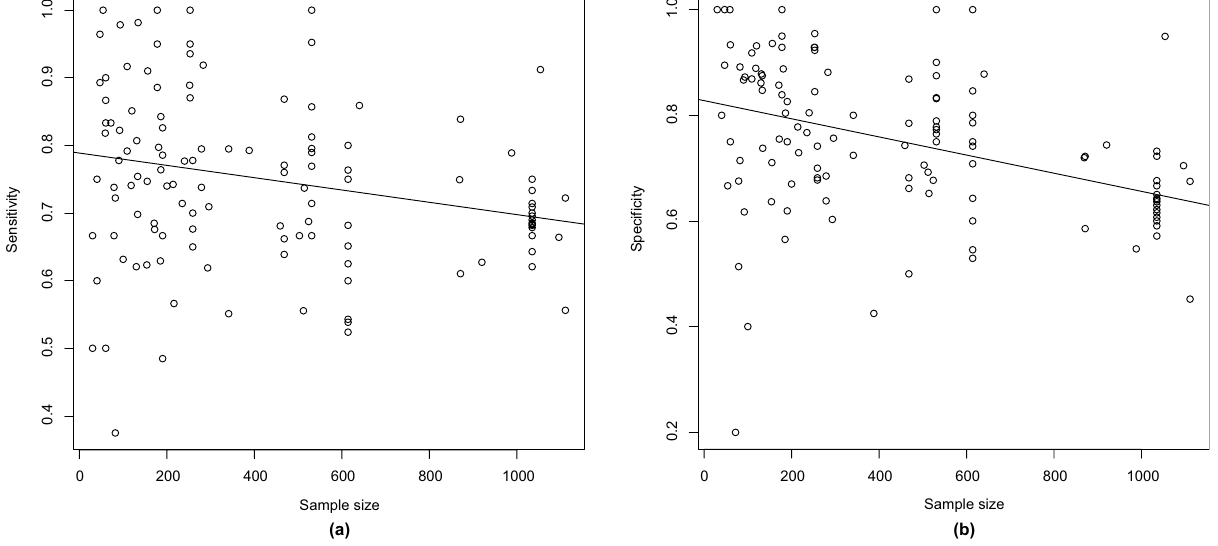
Figure 6. Linear regression models with sample size predicting sensitivity (a) and specificity (b) for all the studies. Created with R Statistics 125 version 4.1.1 using the package mada 126 version